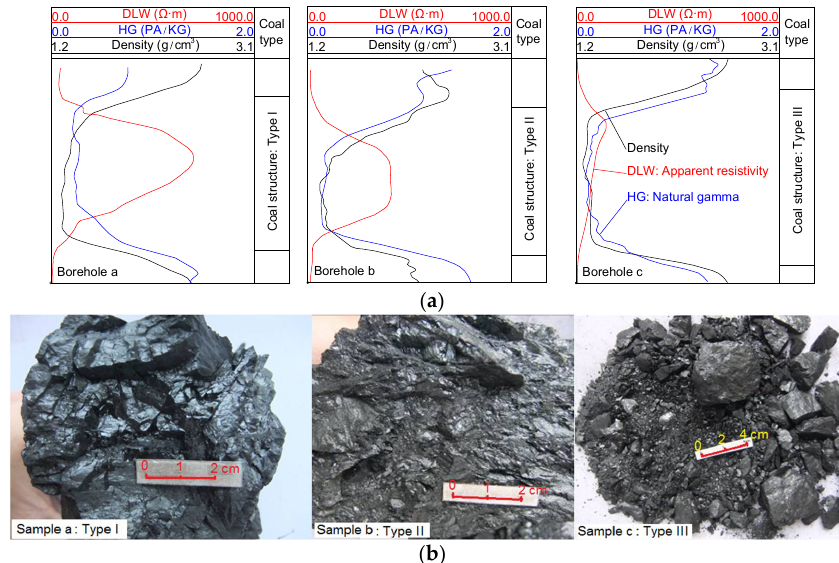
Figure 5. Well logging curves corresponding to different structural types of coals and the apparent characteristics of coals. ( a ) Well logging curves corresponding to different types of coal structures; ( b ) and typical samples of different structural types of coal collected in the pit.